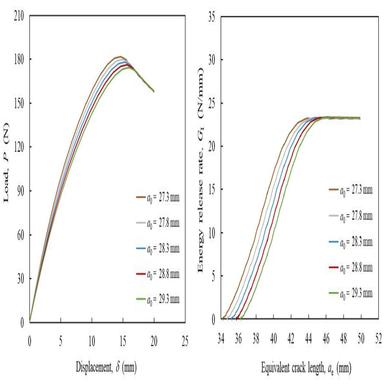
Numerical P-δ curves and R-curves of SLS test specimens considering different a0 values.